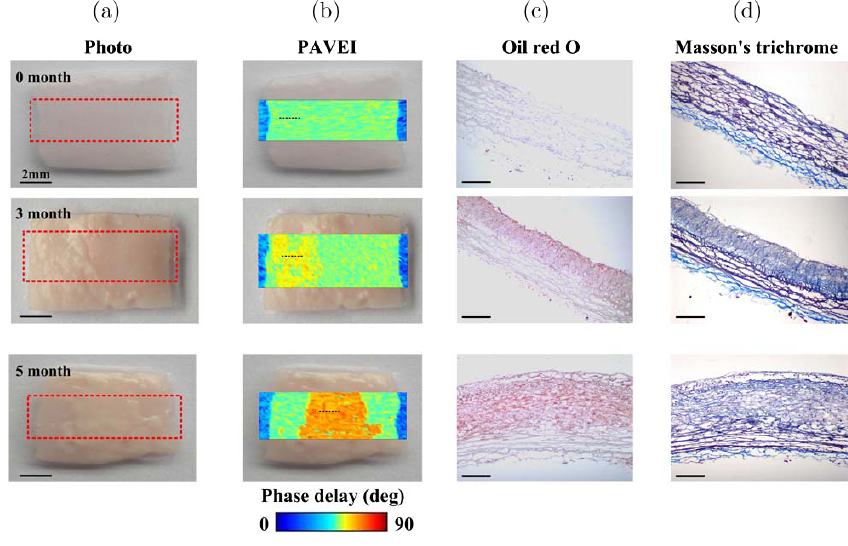
Fig. 8. (a) Photos and (b) representative PAVE images acquired from the luminal surface of the rabbit arteries, with healthy lumen (top row) early atherosclerotic plaque (middle row) and atherosclerotic plaque with higher lipid content (bottom row); (c) the Oil Red O and (d) Masson's trichrome stain images of the areas in the corresponding dashed rectangles. Bars ¼ 300 (cid:3)